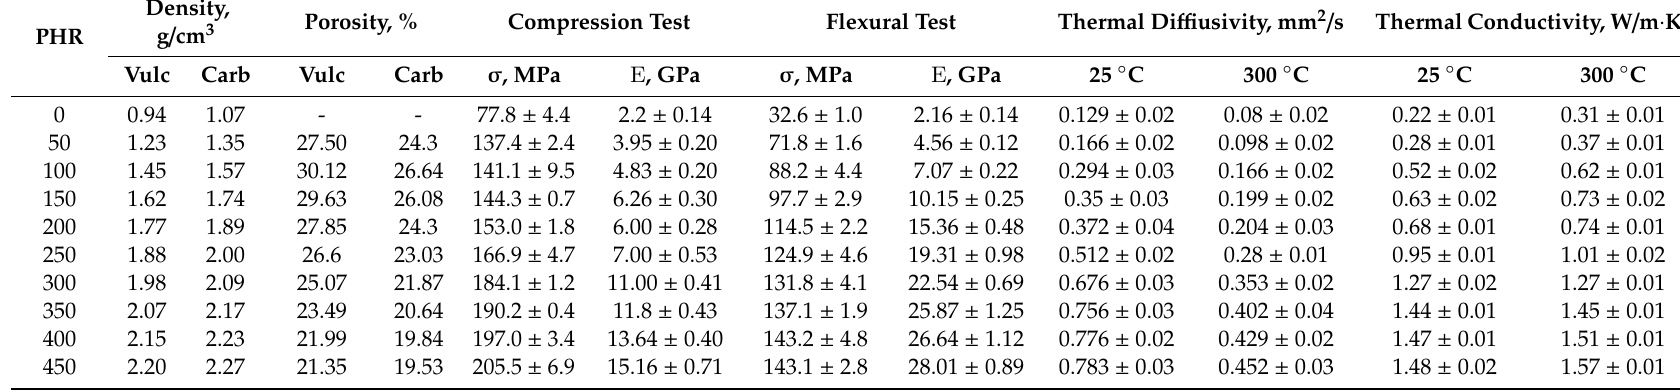
Table 1. Density, porosity, mechanical and thermal properties of NBP-based composites. Mechanical and thermal properties are given for carbonized